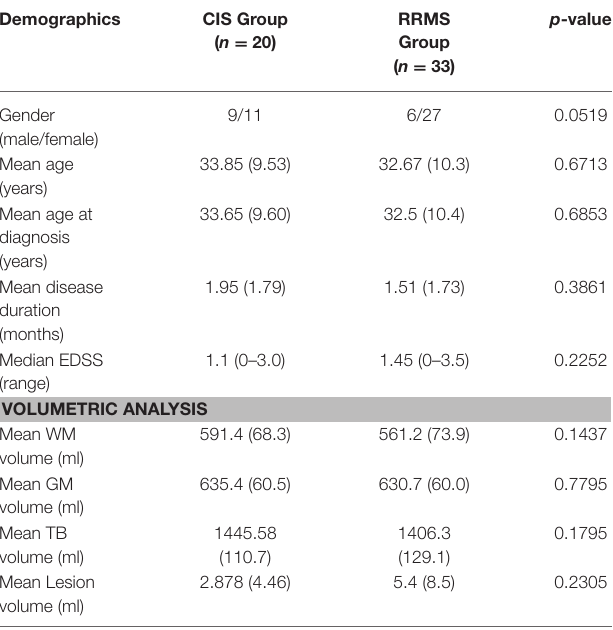
TABLE 1 | Demographic data and MR volume measurements for the CIS and RRMS patient